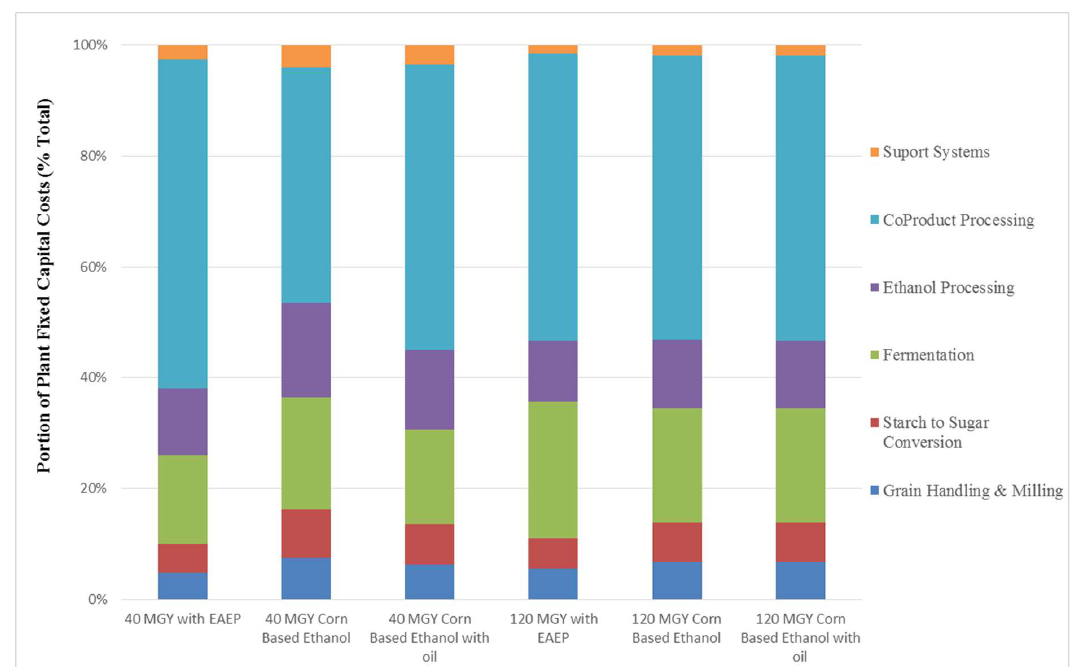
Figure 2. Capital costs for integrated corn-soy ethanol fermentation processing. Scenarios include a 40 million gallon per year (MGY) ethanol plant with or without corn oil separation, a 120 MGY ethanol with or without corn oil separation, and a 40 or 120 MGY ethanol plant, without corn oil separation but with EAEP products used for fermentation.